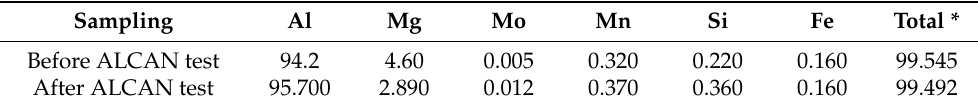
Table 4. The OES elemental analysis of the molten Al-Mg alloy in the crucible before and after the ALCAN immersion test.